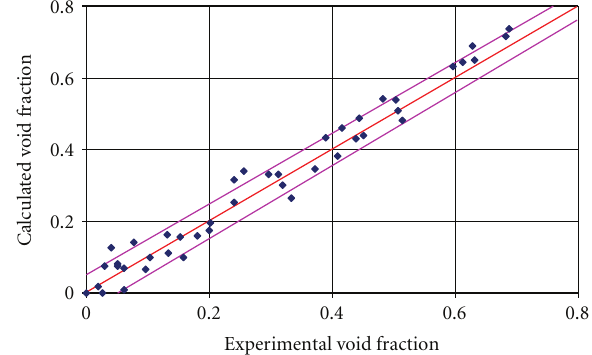
Figure 2: Comparison between calculated and measured void frac- tion for subchannel type S2.